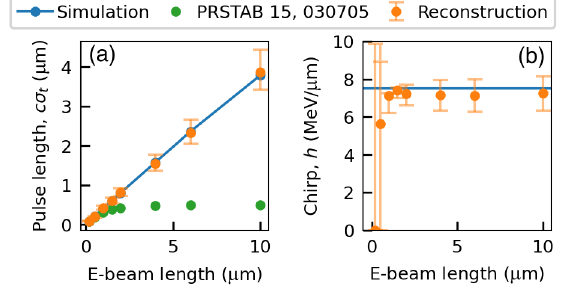
FIG. 3. Results for a scan of the e-beam length in 1D simulations. The left and right show the x-ray pulse length and e-beam chirp, respectively, as obtained from the simulation (blue), from our reconstruction model (orange), and from the model of [15] (green).